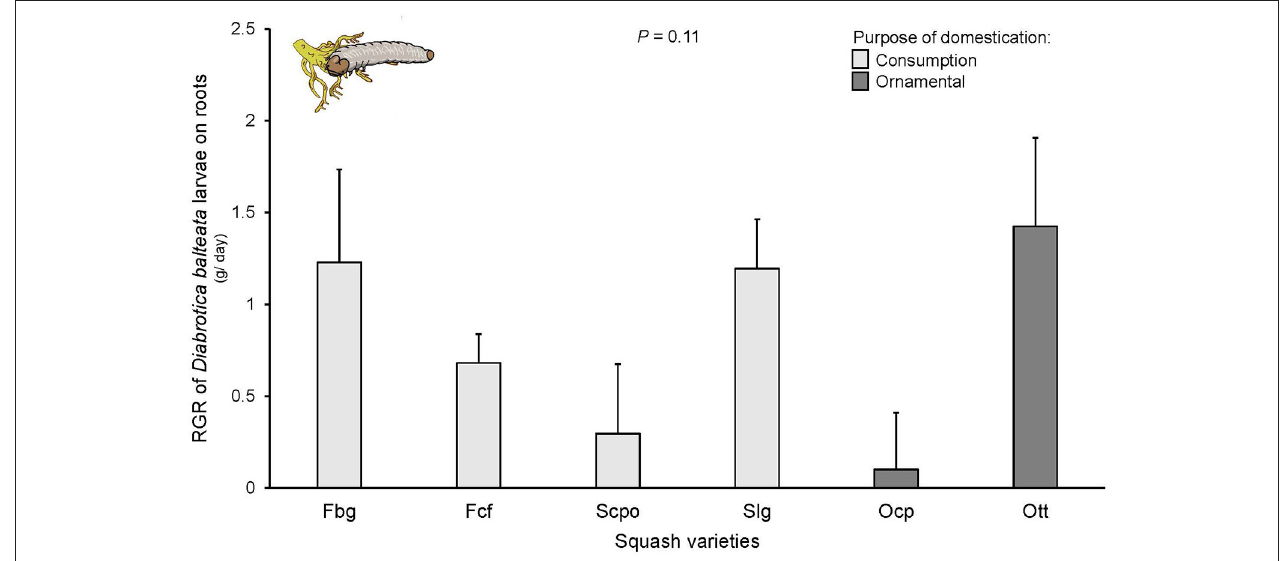
FIGURE 4 | Relative growth rate (RGR) of Diabrotica balteata larvae on roots of squash varieties ( Cucurbita spp.) n = 10–15. Bars represent means ( ± SE). Light-colored bars are varieties domesticated for consumption and dark-colored bars are varieties domesticated for an ornamental purpose. RGR was calculated for groups of larvae as the weight difference between initial and final weight (ln) after 6 days of feeding. P -values are given for treatment [linear mixed